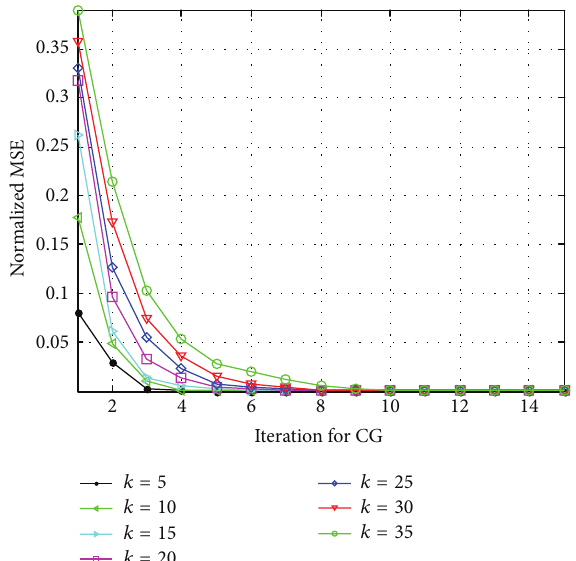
Figure 6: Relationship between precision and iteration times.